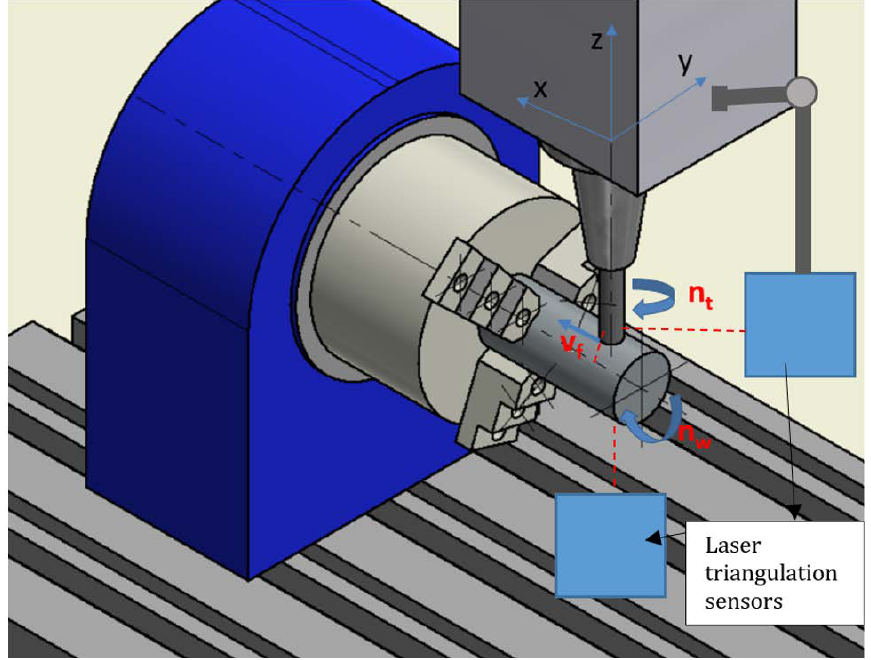
Figure 1. Scheme of the turn-milling station, v f —tool movement speed direction, n t —tool rotation, n w —workpiece rotation. Table 1. Mass fractions of elements in Inconel 718